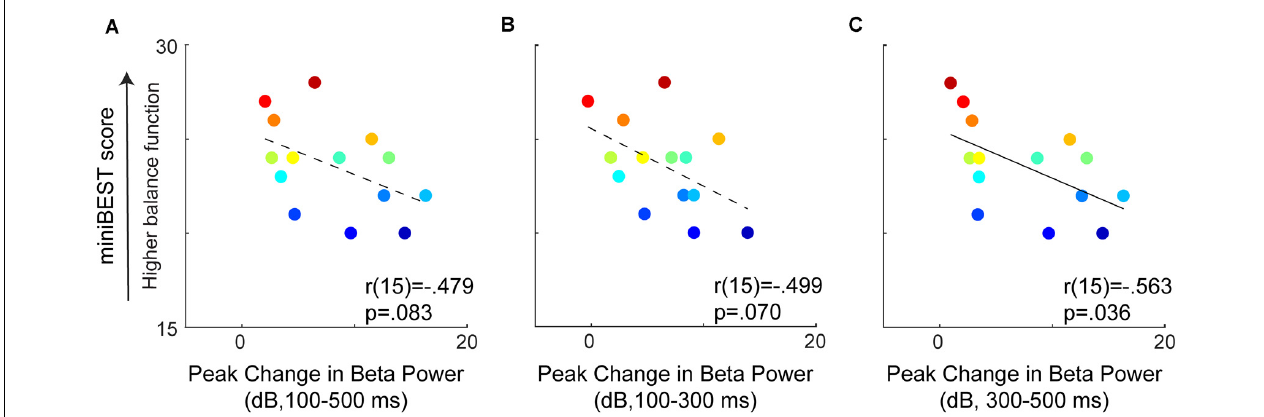
FIGURE 4 | Relationships between perturbation-evoked beta power (baseline subtracted) during overall (A) , early (B) , and later-phase balance reactions (C) . No relationships were observed between perturbation-evoked beta power during overall (100–500 ms) or early-phase (100–300 ms), but later-phase (300–500 ms) perturbation-evoked beta power was negatively associated with miniBEST score. Individual color bar scaled by miniBEST score throughout (red = highest miniBEST, blue = lowest